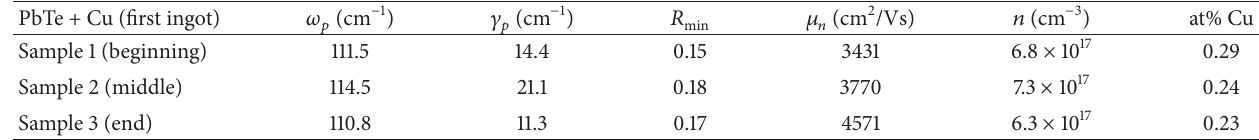
Table 2: Calculated parameters for PbTe doped with Cu (first ingot).